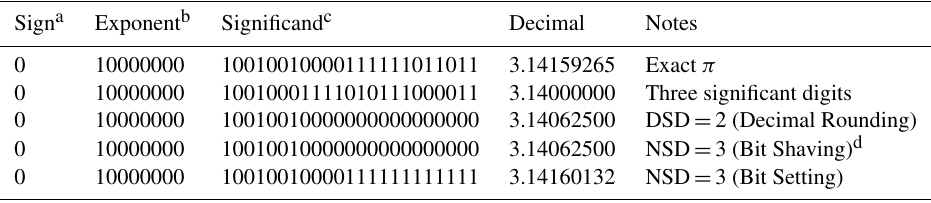
Table 1. Exact and lossy IEEE single-precision floating-point Pi. IEEE-754 single-precision binary representations of π stored exactly, with 3 significant digits, and with three quantization algorithms.